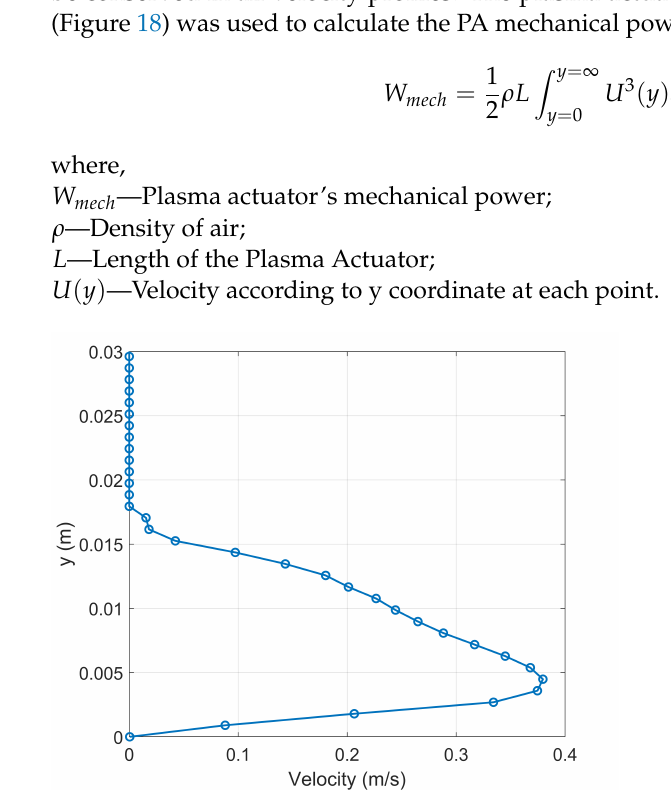
Figure 18. Velocity profile of a Plasma Actuator at a distance of 60 mm from the covered